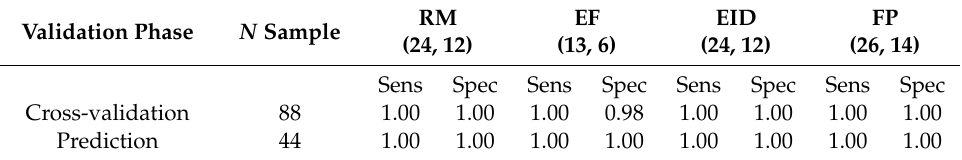
Table 2. Results of PartialLleast Square–Discriminant analysis for sausage process stage identification: sensitivity (Sens) and specificity (Spec) values of models based on MicroNIR data. Raw material, RM; end of fermentation, EF; end of intense drying, EID; and final product, FP. In between brackets, the number of samples used for each single class for model calibration and prediction are